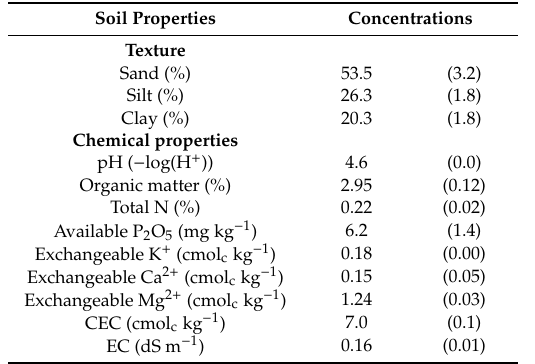
Figure 1. The location of the Pinus rigida plantation in the Forest Technology and Management Research Center in Pocheon and sampling plots of this study. Table 1. Soil characteristics of the research area in the Pinus rigida plantation. Total N, CEC and EC represent the sum of organic N and inorganic N, cation exchange capacity, and electrical conductivity, respectively. Parentheses denote standard errors ( n =